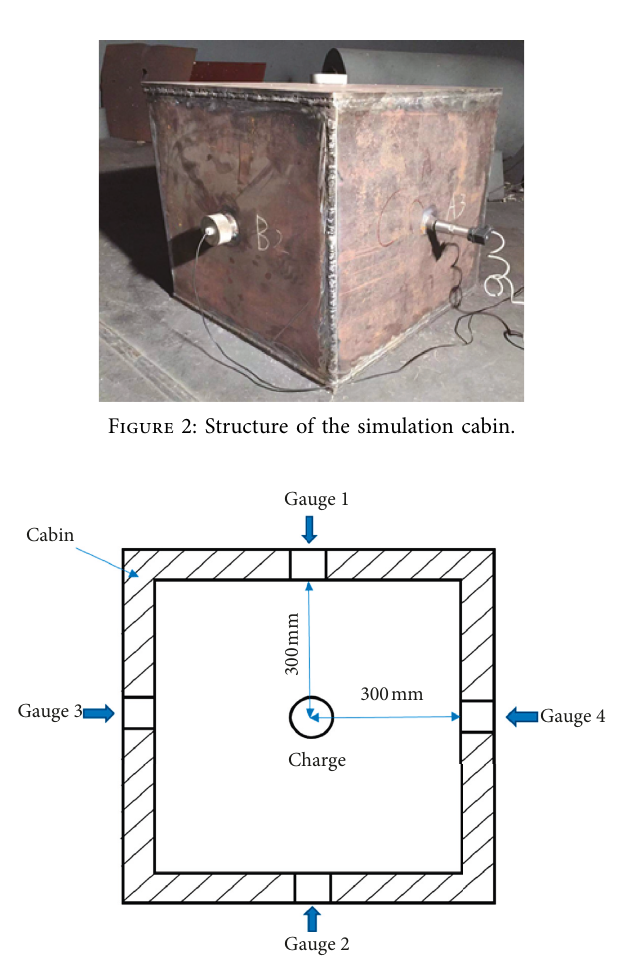
Figure 3: The diagram of interior view of the experimental